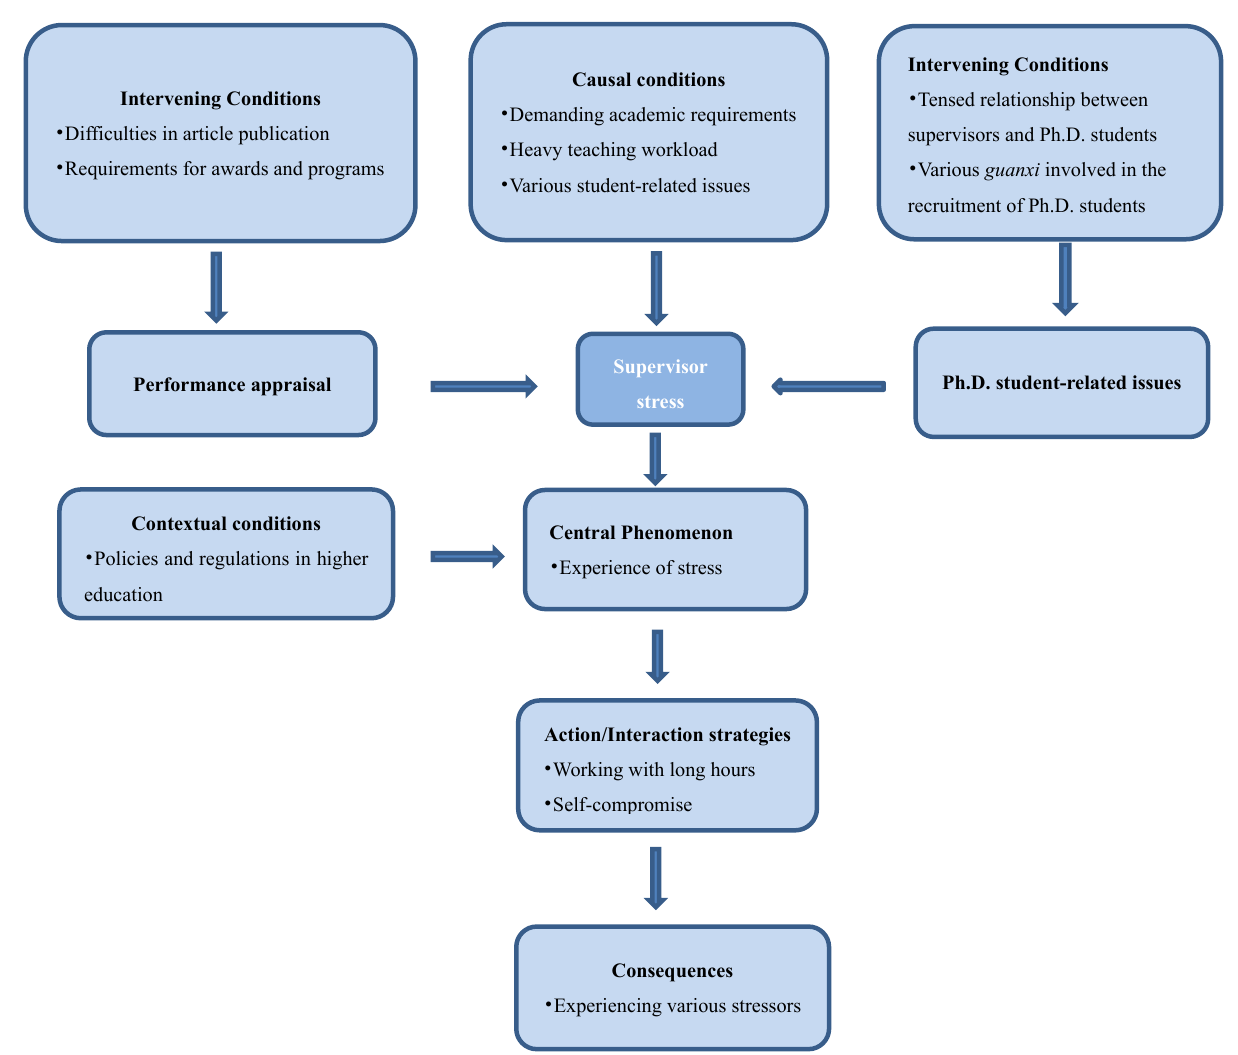
Figure 1. Paradigm model of occupational stress suffered by Chinese doctoral supervisors